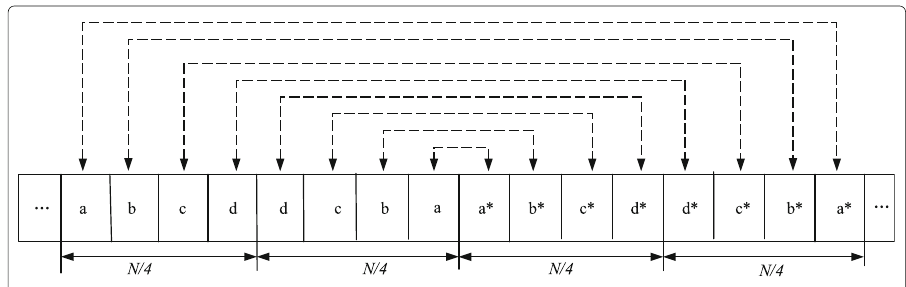
Fig. 3 Ideal time domain symbol structure of Park algorithm